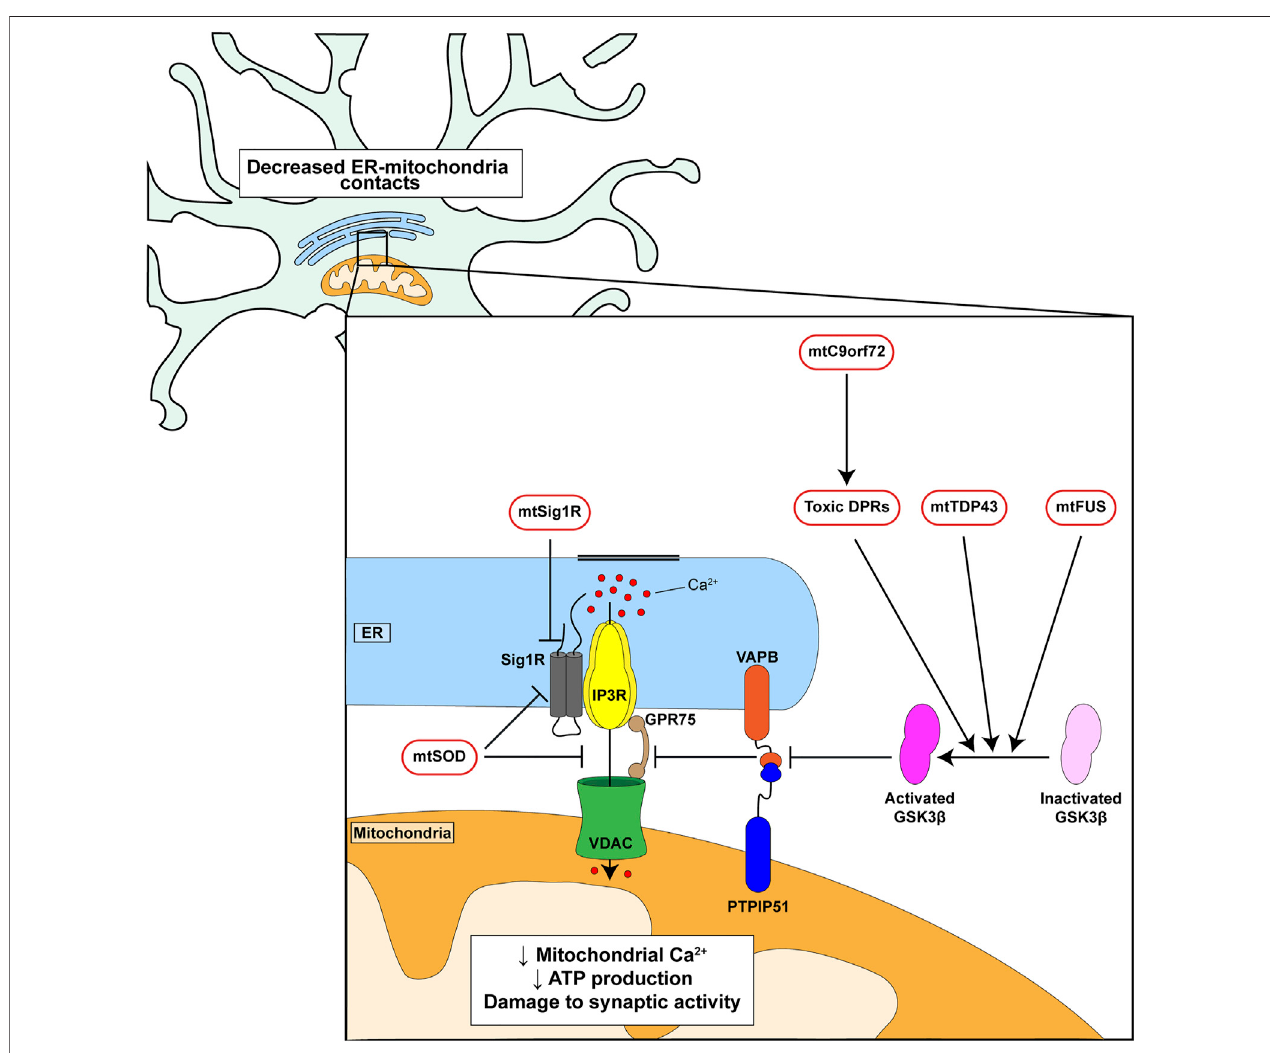
FIGURE 2 | Genetic insults linked to familial FTD/ALS disrupt ER-mitochondria signaling and the VAPB-PTPIP51 interaction. C9orf72 -derived toxic DPRs, mutant TDP43 and mutant FUS all activate GSK3 β which in turn disrupt binding of VAPB to PTPIP51. Mutant Sigma1 receptor perturbs IP3 receptor mediated delivery of Ca 2+ from ER to mitochondria. Mutant SOD1 may act directly on the Sigma-1 receptor and/or target the IP3 receptor-VDAC1 interaction.